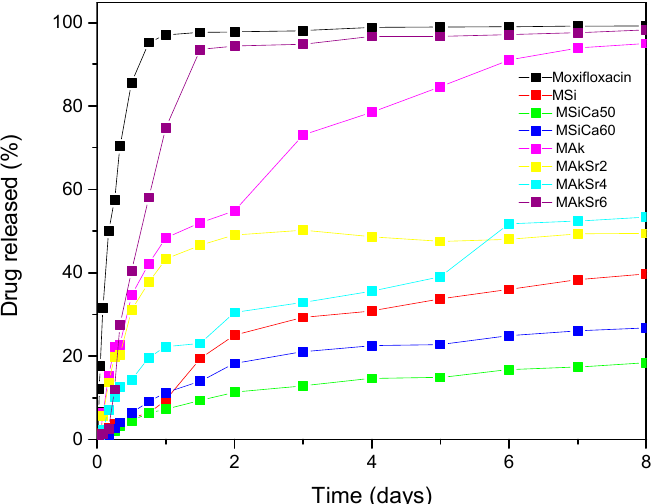
Figure 9. In vitro release rate of moxifloxacin from mesoporous silica-based nanoparticles (MSNs) at pH 7.4.